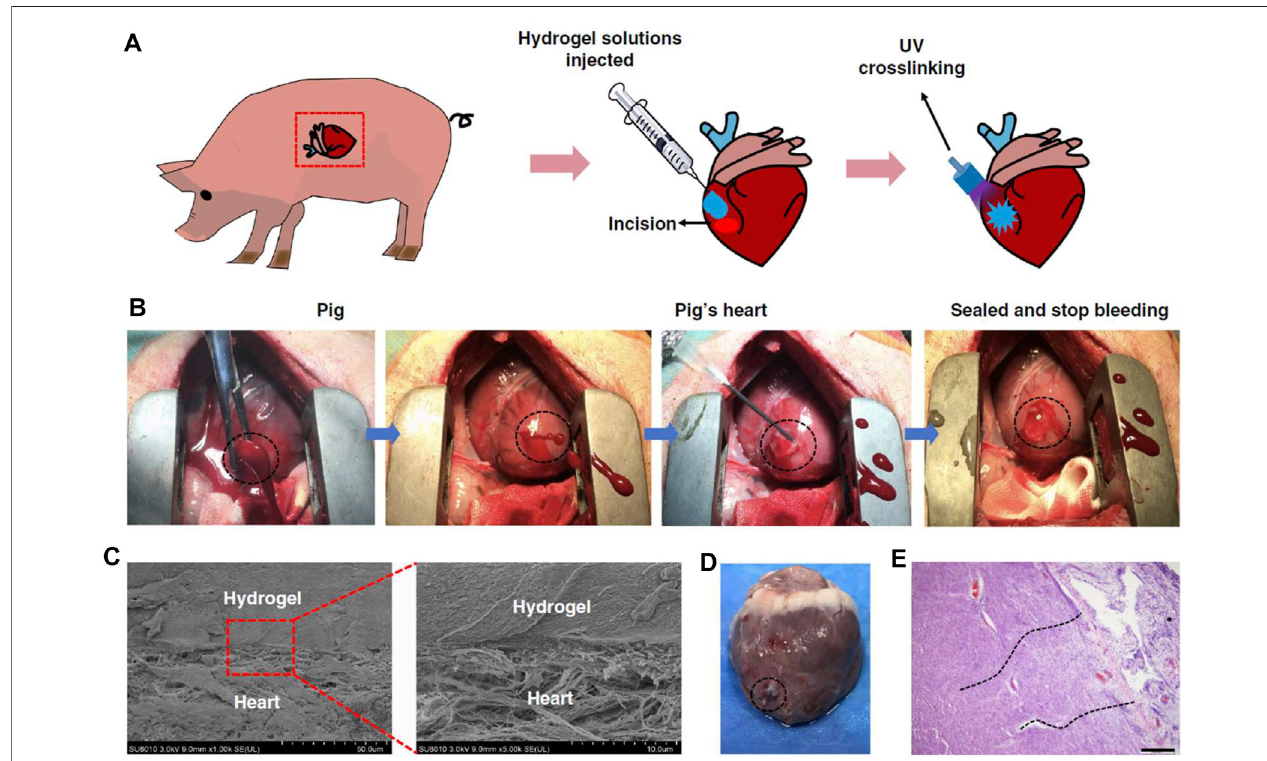
FIGURE 3 | Hemostatic properties of the matrix gel in a pig cardiac puncture injury model. (A) Schematic diagram of the surgical procedure. (B) Gross view of the rapid hemostasis and sealing following cardiac puncture injury. (C) Scanning electron micrographs of the interface between the pig heart puncture wound and the hydrogel. Scale bar: 50 μ m (left plates); 10 μ m (right plates, enlarged). (D) Images of a heart autopsy following killing after two 2 weeks of postoperative recovery, the hydrogel still adhering to the wound. (E) Tissue staining images of the interface between pig heart cardiac tissue and the matrix gel, after 2 weeks of postoperative recovery. Scale bar: 200 μ m ( n (cid:1) 4). Reproduced from (Hong et al., 2019) with permission from Copyright 2019